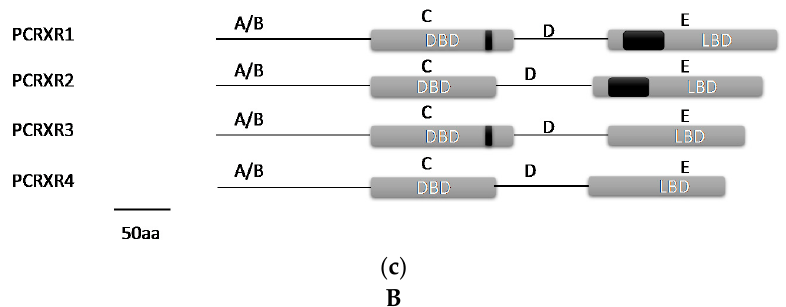
Figure 2. ( A ) The former figure ( a ) is a simple schematic representation of both transcripts highlighting each domain region. The latter figure ( b ) is a comparison between deduced amino acid